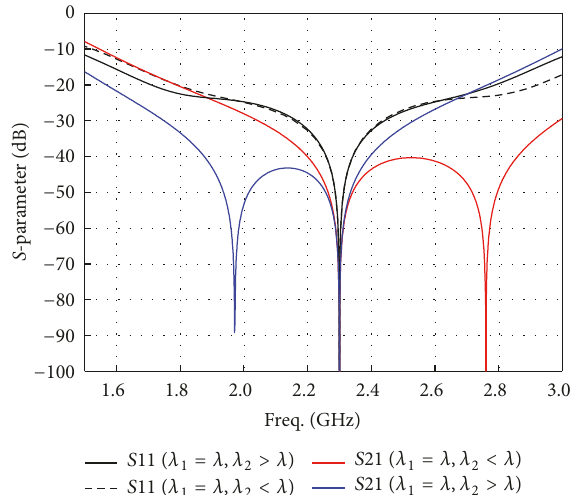
Figure 5: 𝑆 -parameters of the hybrid feeding network with different half-wavelength delay lines of Port 1 and Port